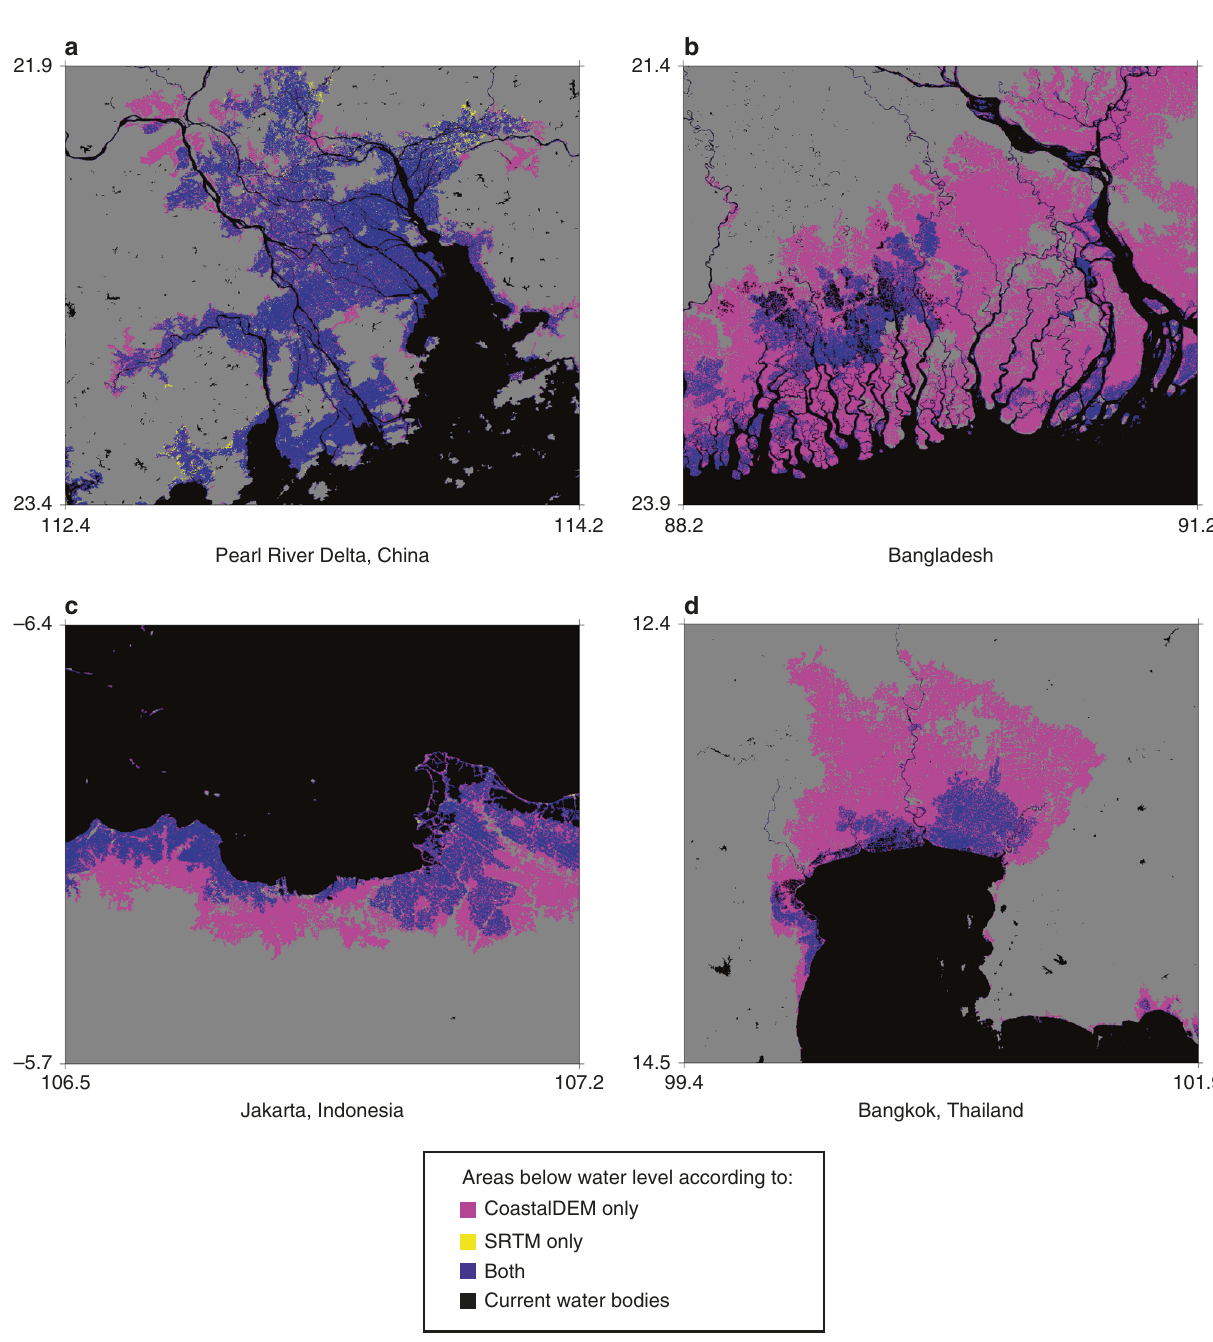
Fig. 1 Permanent inundation surfaces predicted by CoastalDEM and SRTM given the median K17/RCP 8.5/2100 sea-level projection. Locations include ( a ) the Pearl River Delta, China; ( b ) Bangladesh; ( c ) Jakarta, Indonesia; and ( d ) Bangkok, Thailand. Low-lying areas isolated from the ocean are removed from the inundation surface using connected components analysis. Current water bodies are derived from the SRTM Water Body Dataset. Gray areas represent dry land. Axis labels denote latitude and